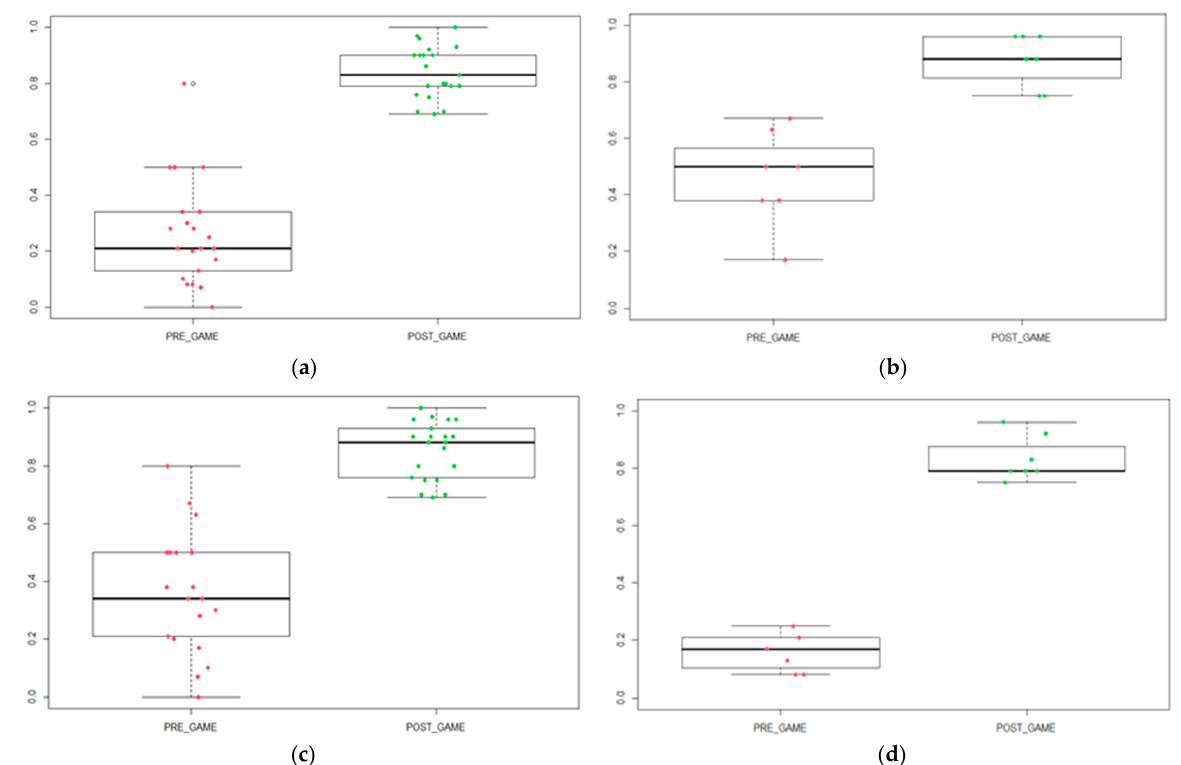
Figure 14. Percentage of correct answers in pre-game and post-Game in different scenarios. ( a ) Undergraduate; ( b ) Graduate; ( c ) Colombia; ( d ) Chile.